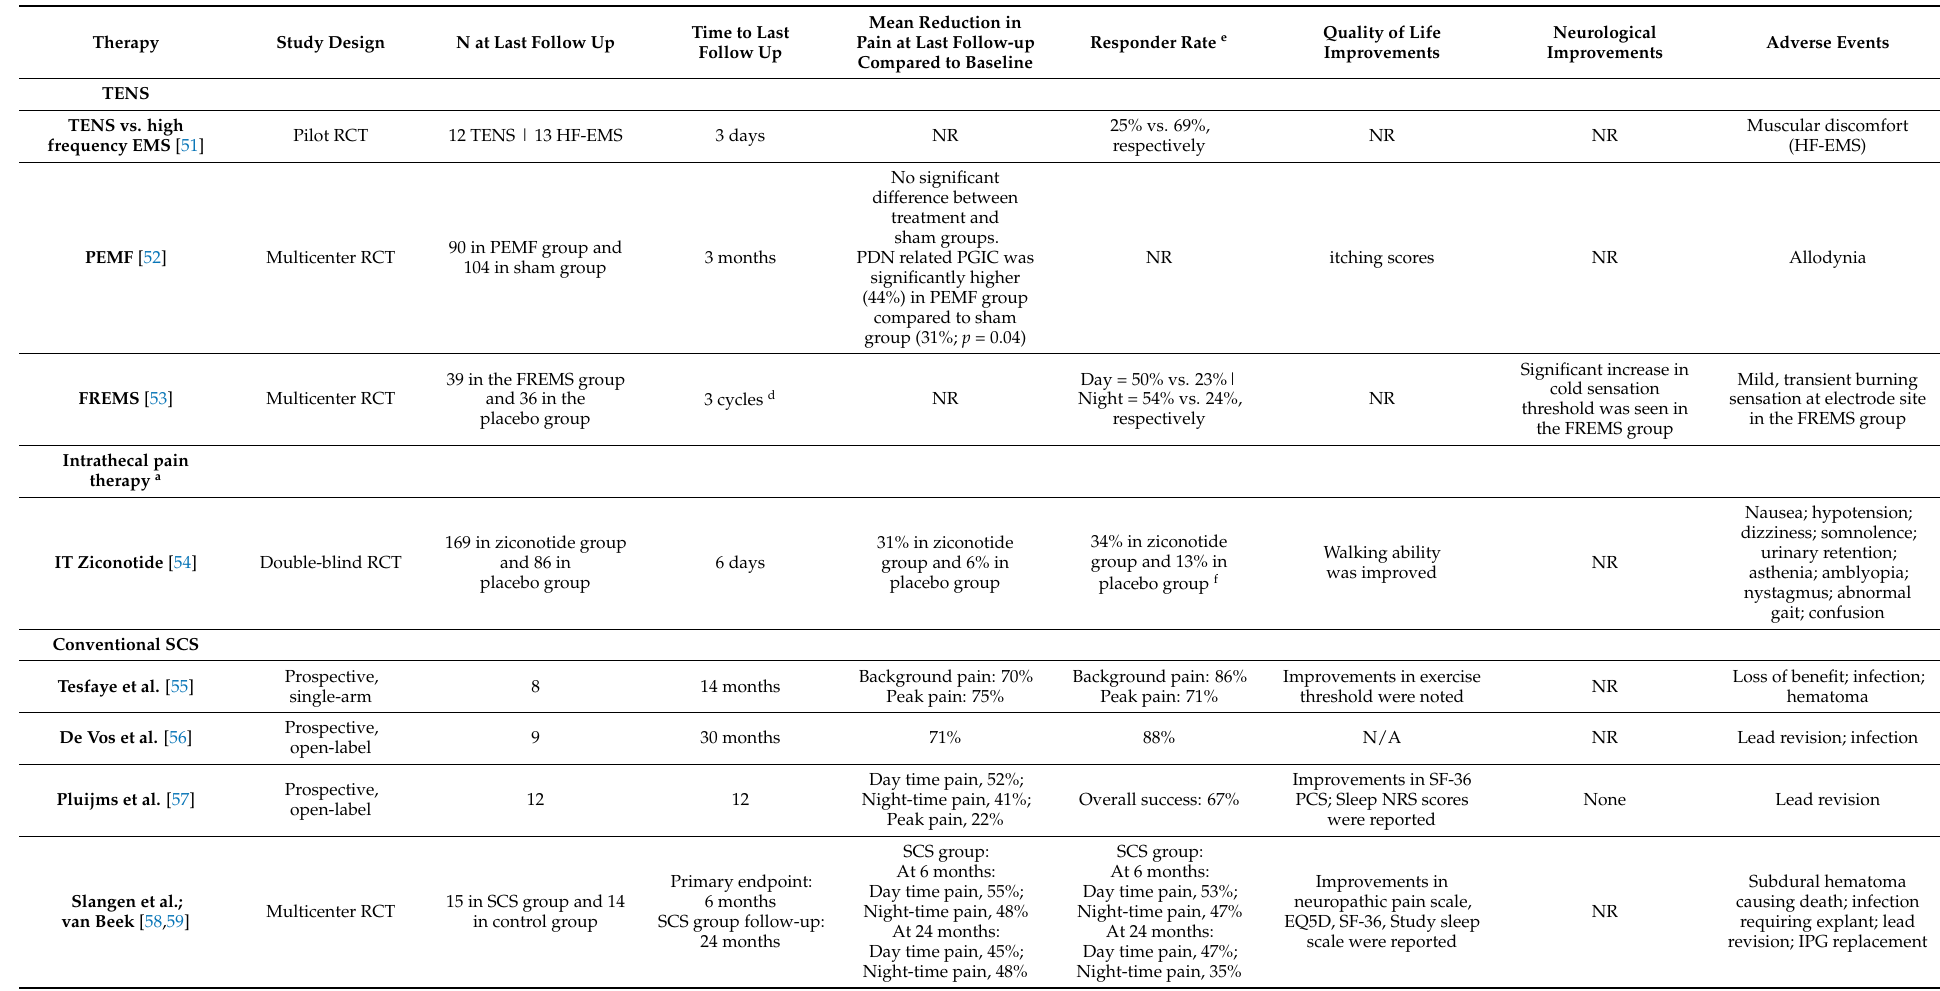
Table 4. Neuromodulation therapies for painful diabetic